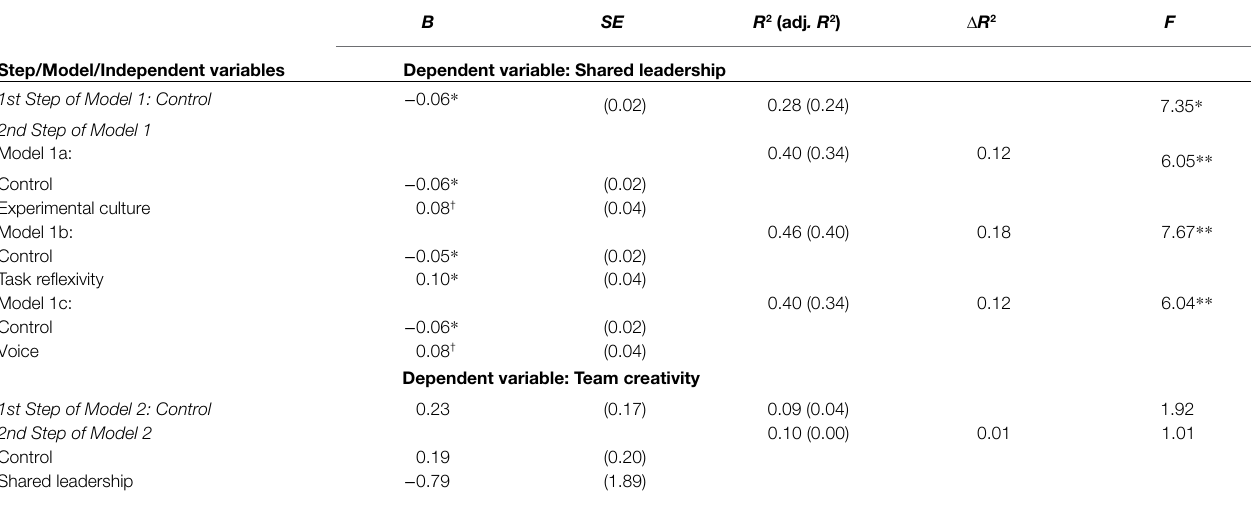
TABLE 5 | Results of regression